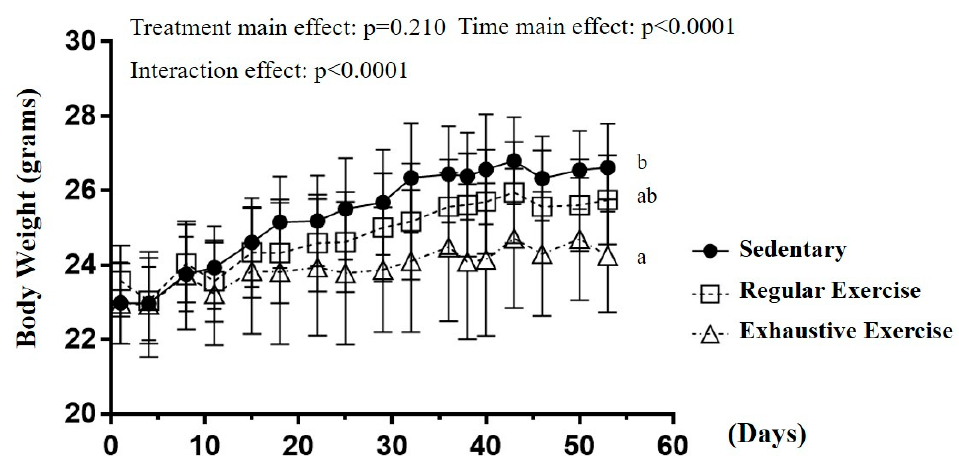
Figure 2. The growth curve with eight-week indicated exercise intervention. Treatments with different letters (a, b) differ significantly at p < 0.05 by using one-way analysis of variance. Table 1. Effects of consecutive exhaustive exercise intervention on body composition and diet. organs, and the diet was recorded as quantity/volume per day (Table 1). The epididymal fat pad mass was significantly different among the groups (F(2, 15) = 8.74, p = 0.003),